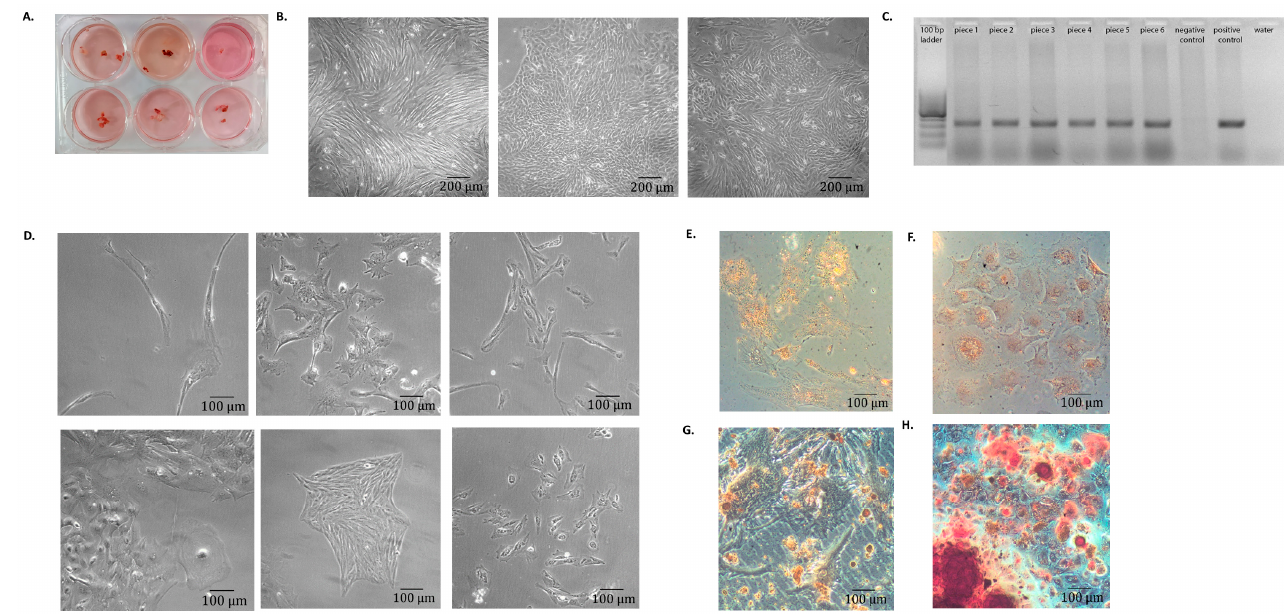
Figure 3. Characteristics of cells that have migrated out of the foci formed under the renal capsule after BM-MSCs implantation. ( A ) Pieces of focus tissue in the wells of a 6-well plate (Pig#99). The approximate size of the pieces was 0.3 × 0.3 cm. ( B ) Morphological heterogeneity of cells that migrated out of the implant (Pig#103). ( C ) Gel electrophoresis of GFP-specific PCR products. DNA of cells that have migrated out of different pieces of the implant was analyzed. ( D ) Cell morphology of various IM-MSC clones (Pig#106). ( E ) Control IM-MSCs stained with Oil Red O. ( F ) IM-MSCs induced to adipogenic differentiation stained with Oil Red O. ( G ) Control IM-MSCs stained with Alizarin red. ( H ) IM-MSCs induced to osteogenic differentiation stained with Alizarin red. Magnification 10×.